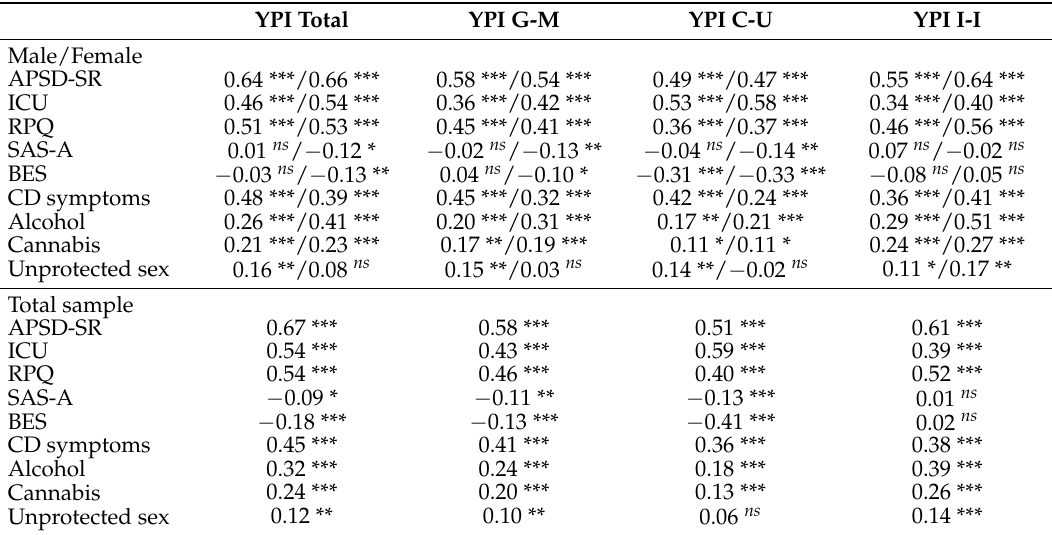
Table 5. Correlations of the YPI total and its dimensions with other measures and variables